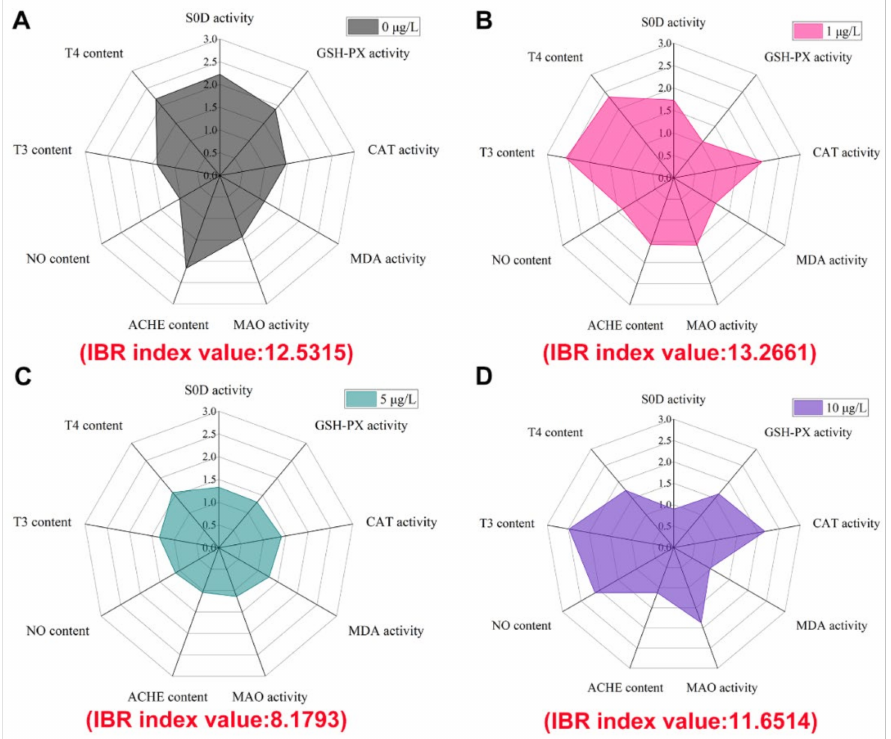
Figure 4. Star plot and IBR index values of normalized biomarker data in different groups. ( A ) 0 µ g/L; ( B ) 1 µ g/L Hg 2+ ; ( C ) 5 µ g/L Hg 2+ ; ( D ) 10 µ g/L Hg 2+